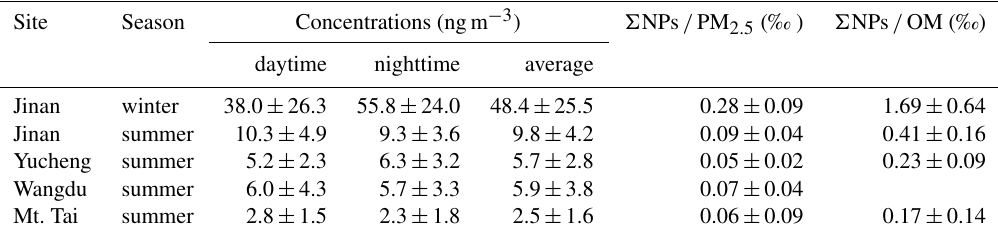
Table 2. Average concentration levels of total particulate nitrated phenols ( (cid:54) NPs) and the proportions in PM 2 . 5 and fine organic matters. Site